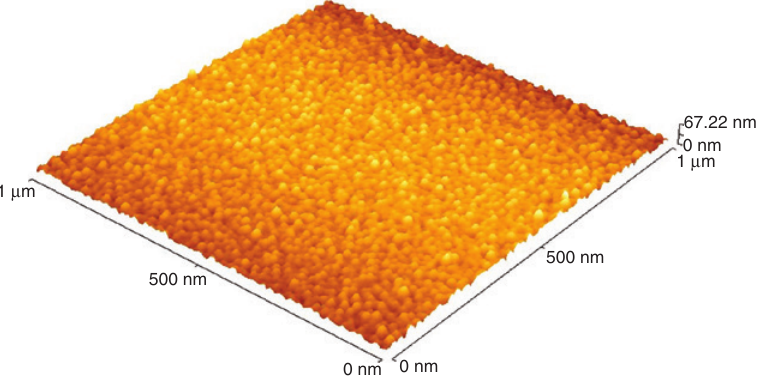
Figure 2: AFM image of formed nanoparticles after pretreatment process, which is consistent with Figure 1B.